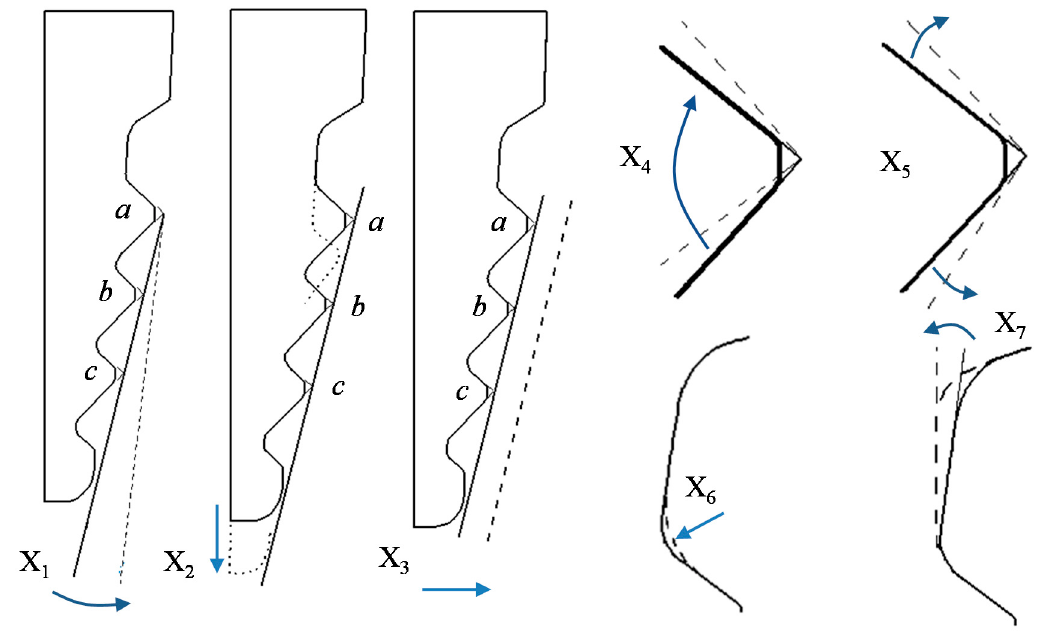
Figure 6. Basis vectors to change shape of fixed part.